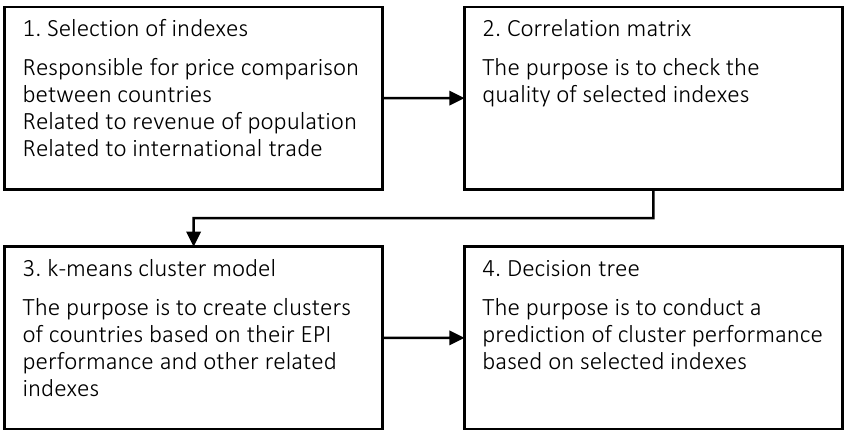
Figure 1. Model for assessing the impact of price levels and purchasing power on environmental performance in different